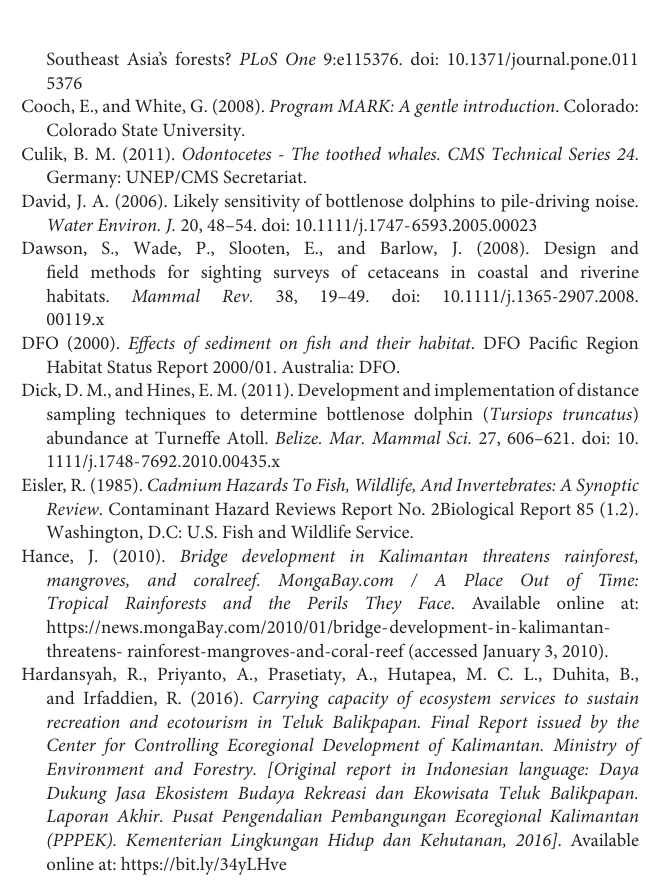
FIGURE S1 | Satellite images showing the mangrove conversion on the right shores of the bay for expansion of Kariangau industrial areas over the years (left-2001; right-2015). TABLE S1 | Questioner with fishermen in Balikpapan Bay (translation from bahasa